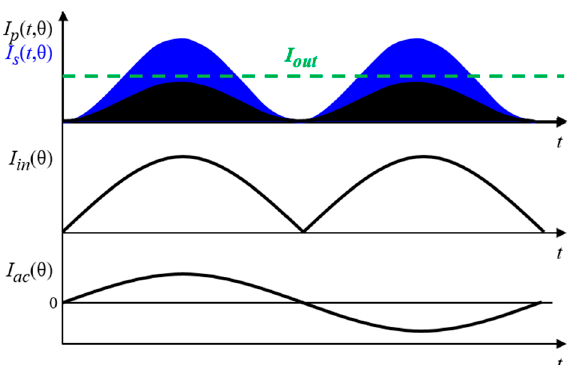
Figure 10. Current waveforms of the circuit in Figure 7: line cycle time scale of the primary current I p , secondary current I s , input rectified current I in and current in the ac side I ac .